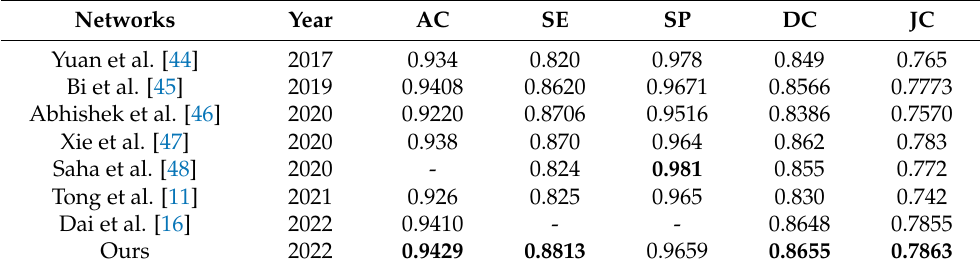
Table 4. Testing results of our method and other advanced methods on the ISIC-2017 dataset.